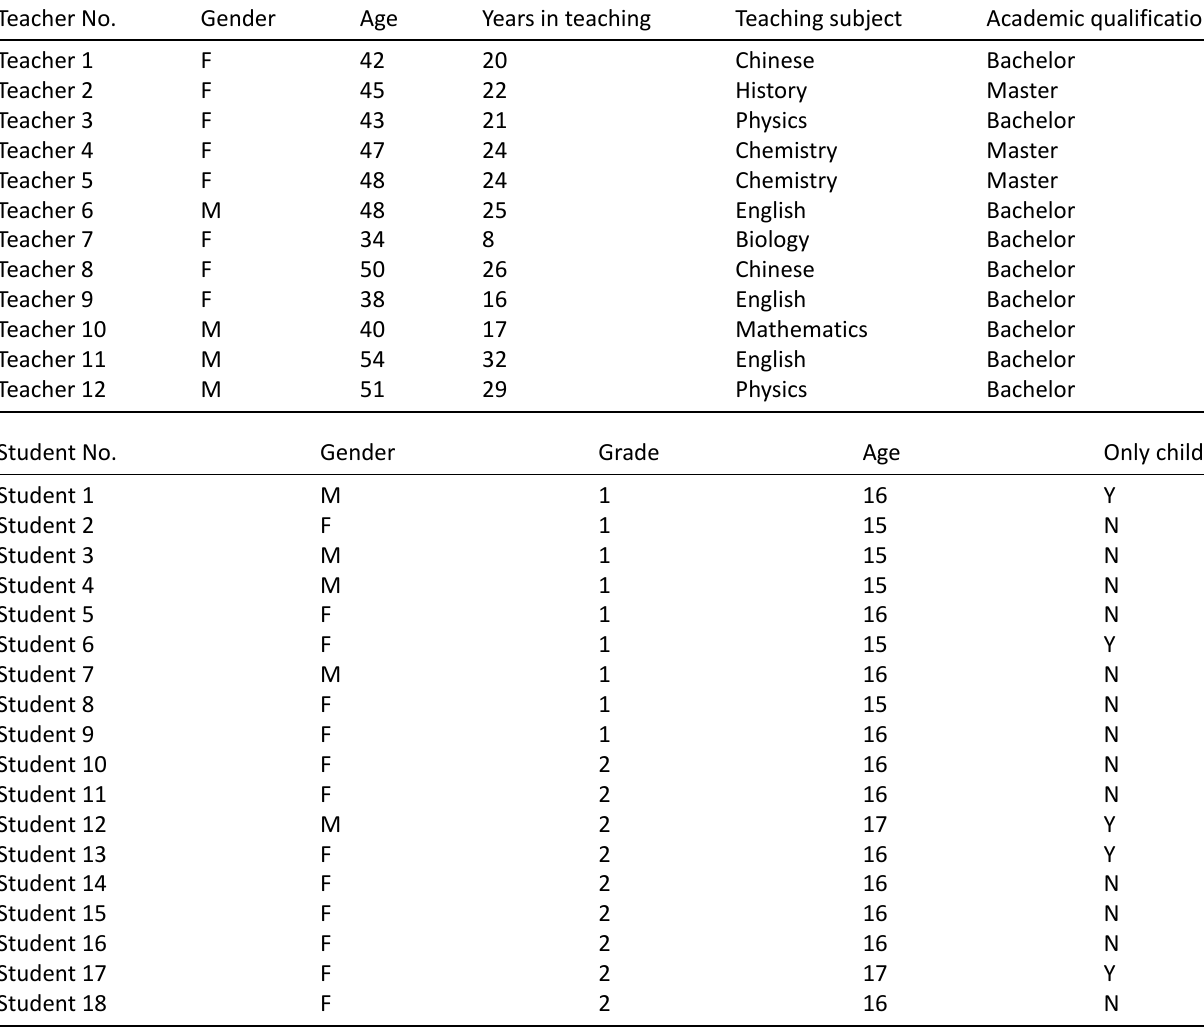
Table 1. Backgrounds of the